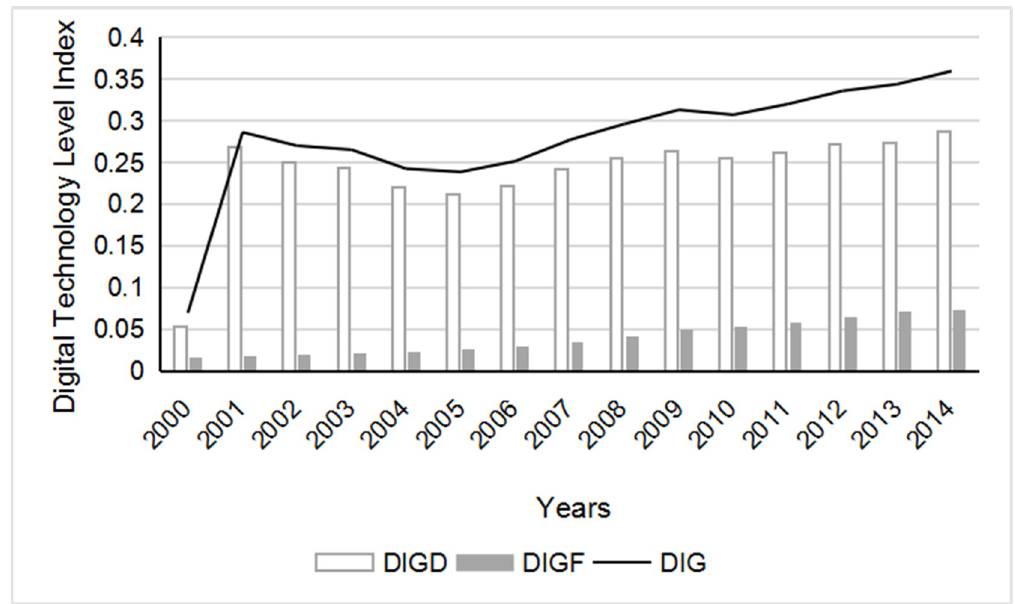
Fig 2. China’s manufacturing digital technology level